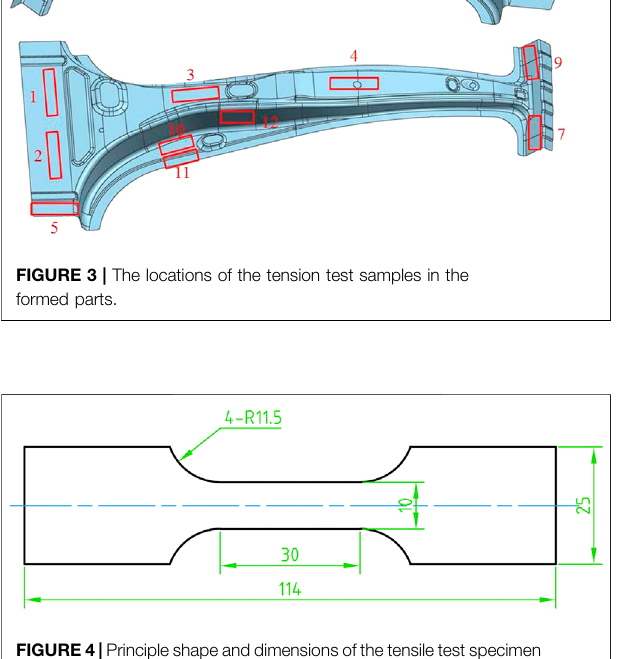
FIGURE 4 | Principle shape and dimensions ofthe tensile test specimen (unit: